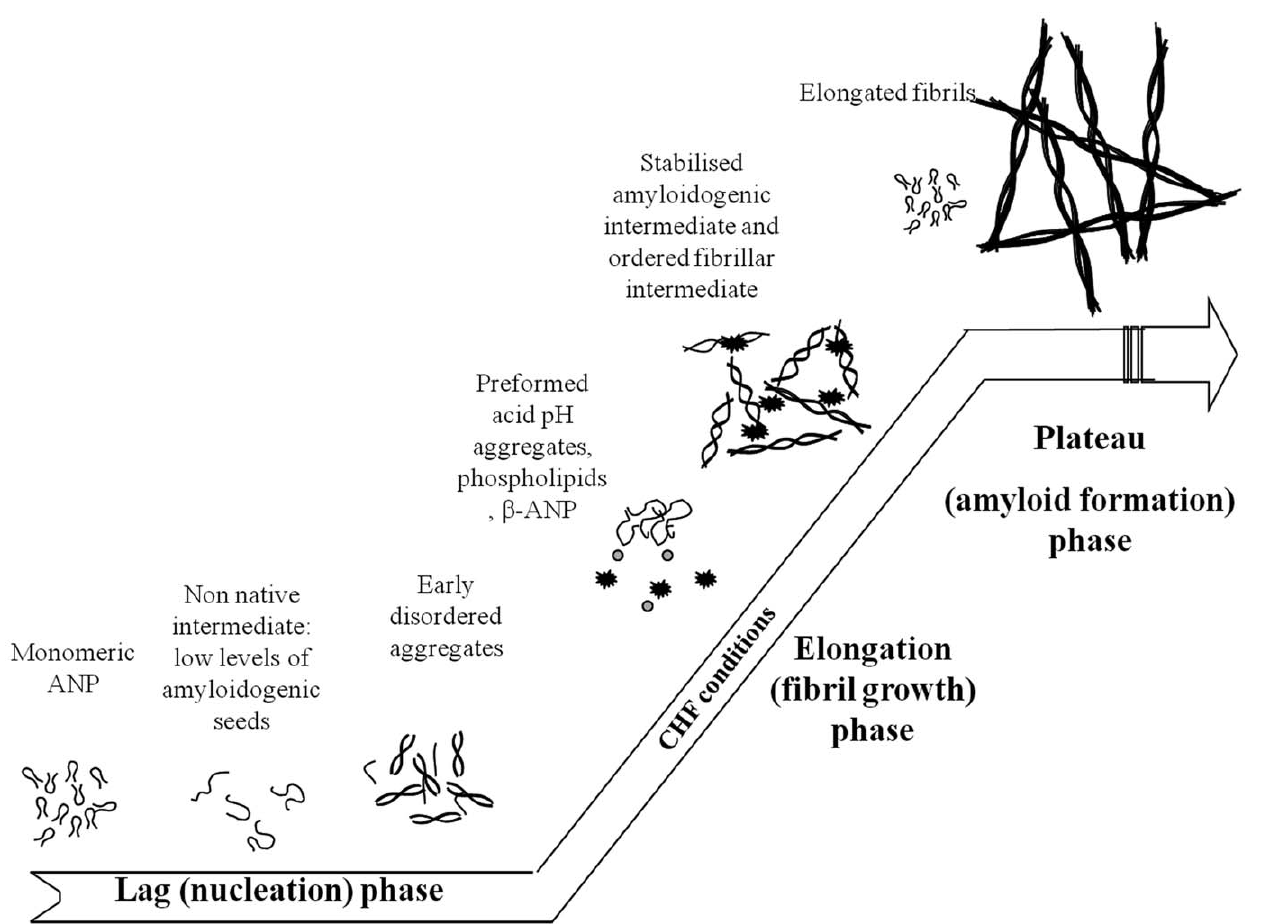
Figure 8. Theoretical schema of ANP aggregation.